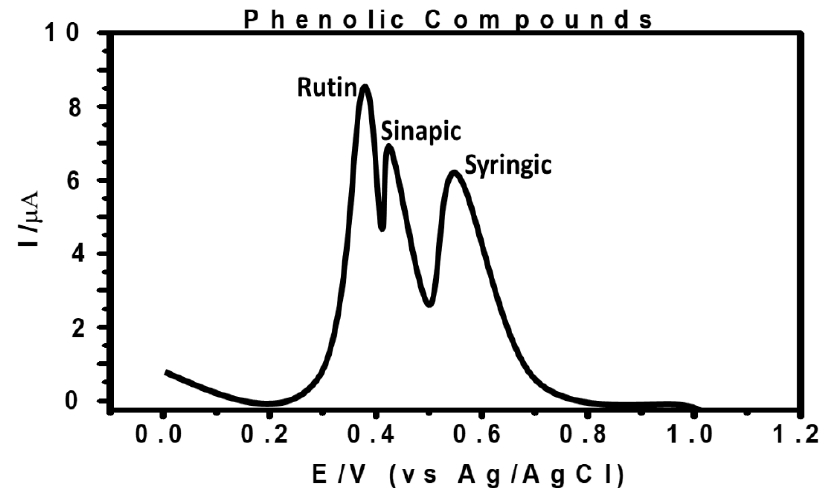
Figure 9. Differential pulse voltammogram showing three phenolic compounds’ simultaneous determination with 4.5 × 10 − 3 M for sinapic acid, 5.1 × 10 − 3 M for syringic acid, and 1.6 × 10 − 3 M for rutin respectively at MCPE in 0.5 M ABS with pH 4.8, recorded at 0 V to +1.0